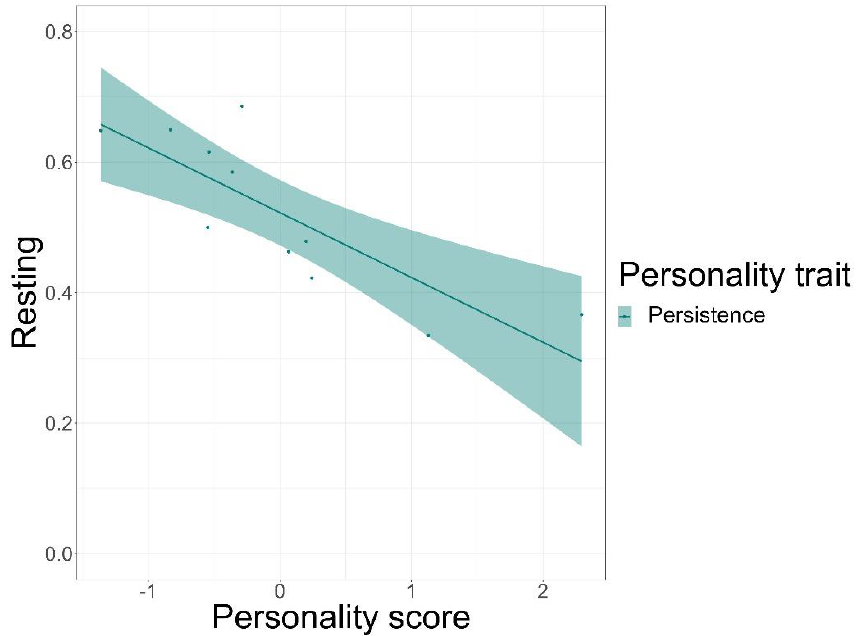
Figure 5. Time spent resting in percentages and its relation to the personality scores of the trait of persistence. The solid line is a trend line surrounded by the 95% confidence interval.